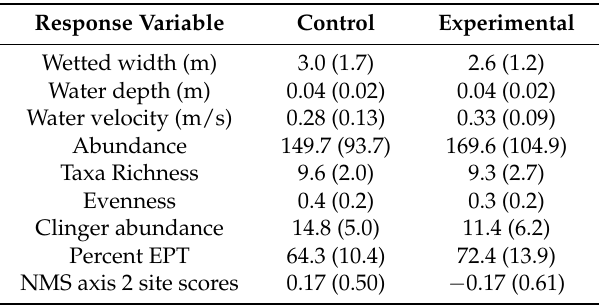
Table A2. Means (SD) of hydrologic and macroinvertebrate community response variables that did not differ between control and experimental riffles within three agricultural headwater streams of upper Alum Creek, 5–14 June 2015.